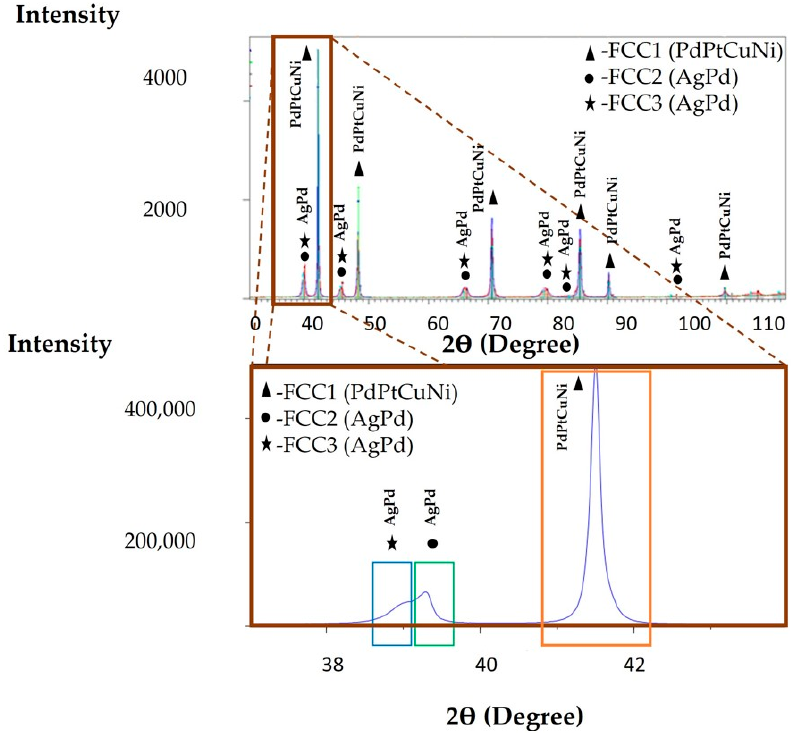
Figure 6. XRD analysis of the cast CCNA sample and XRD analysis in the range 37–44 θ .